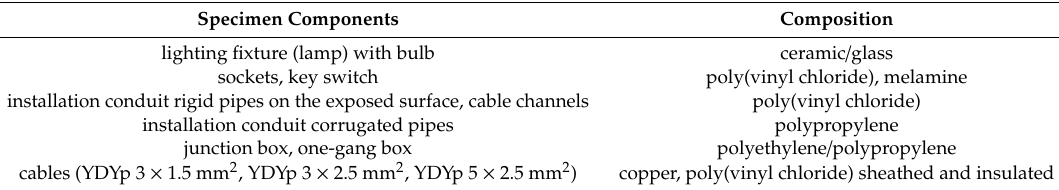
Table 1. Composition of electrical installation